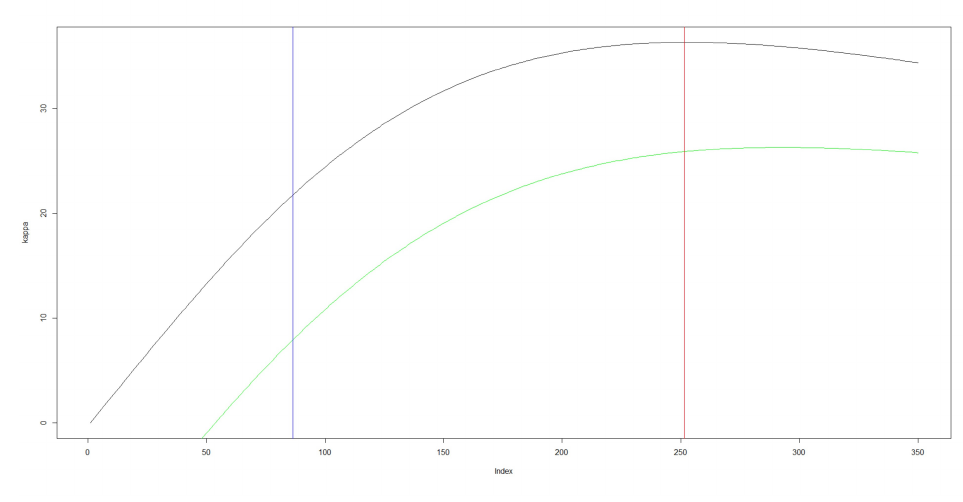
Figure 9. Variation of κ and ν